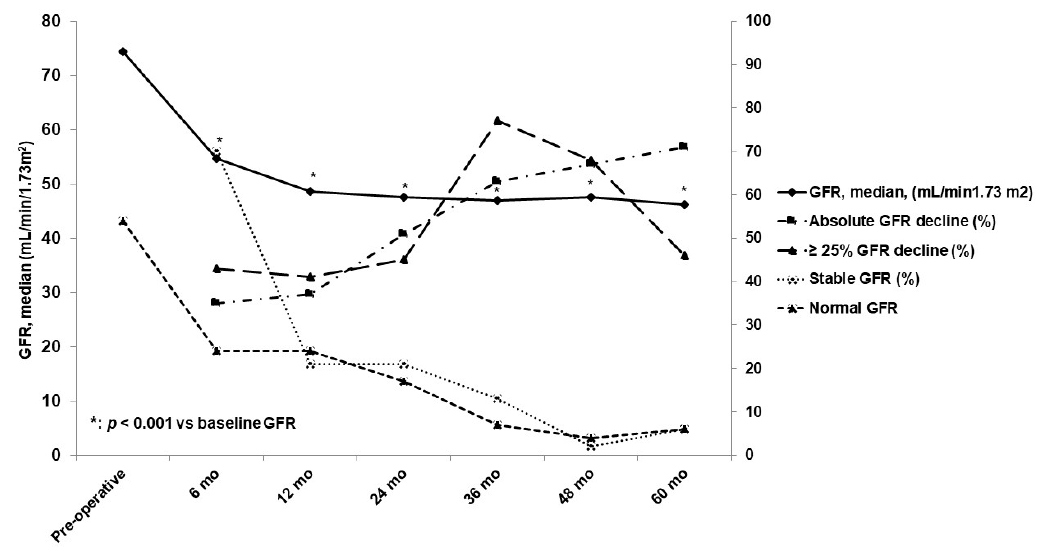
Figure 1. Changes in glomerular filtration rate (GFR) over time in the whole cohort.